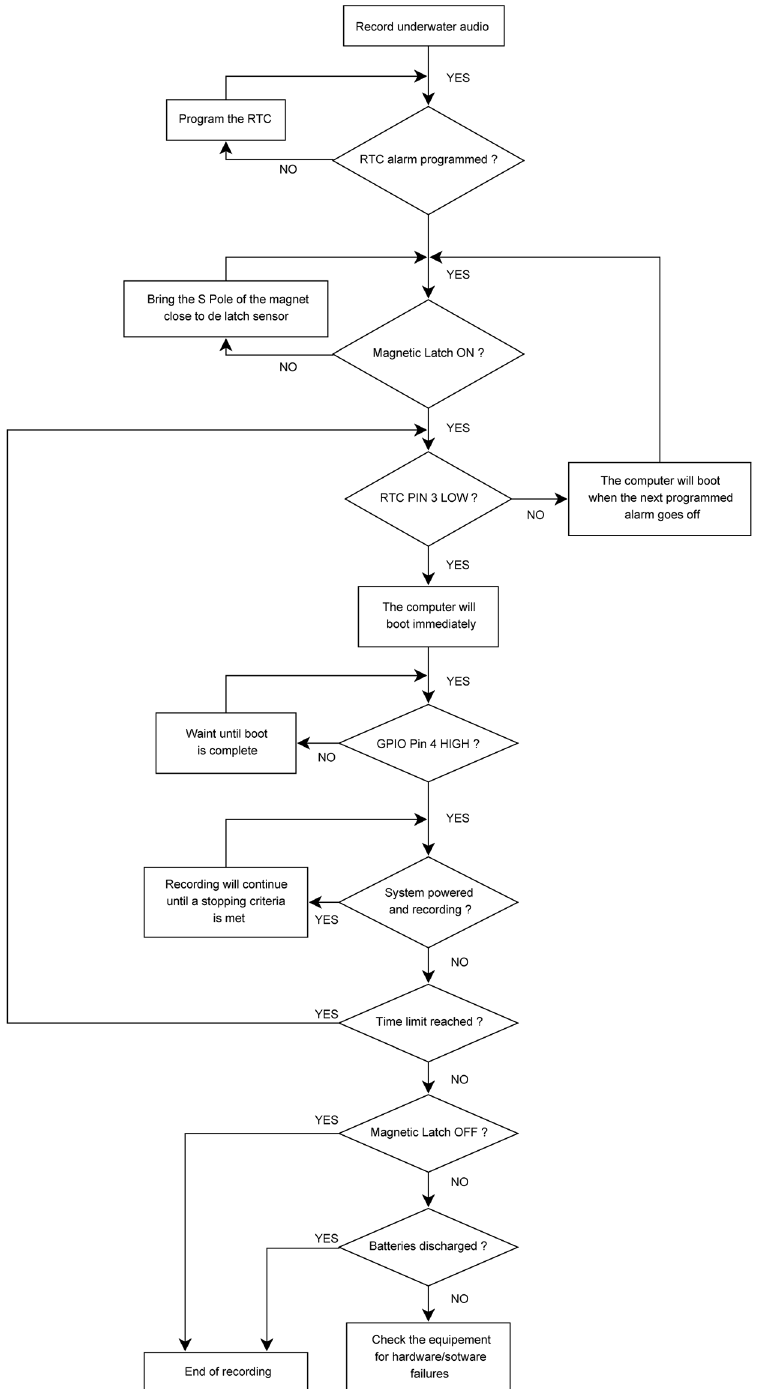
Fig 5. Flow chart of the procedure used to perform scheduled recordings using the resources of the RTC.